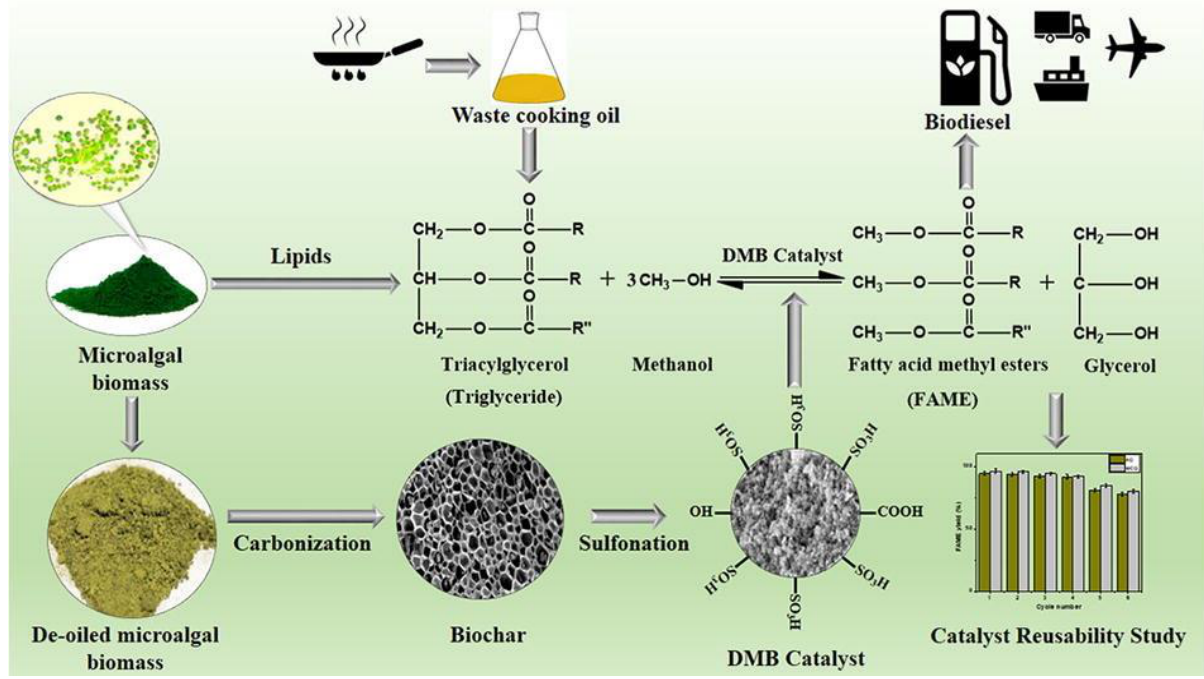
Figure 9. Pictorial representation of biodiesel synthesis using de-oiled microalgal biomass by car- bonization, followed by sulfonation, to synthesize a new carbon-based solid acid catalyst. Reprinted with permission from Ref. [87]. 2021, Elsevier. Table 1. Biomass-derived heterogeneous catalysts for biodiesel